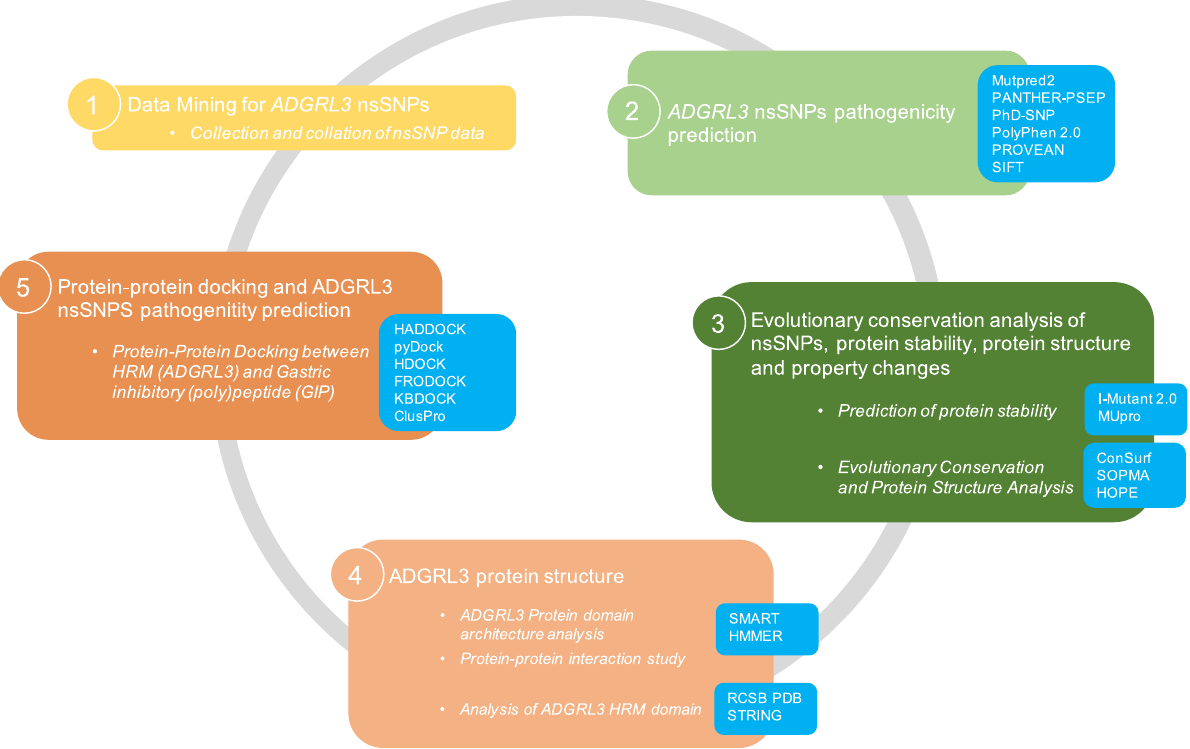
Figure 6. Flow diagram for the in-silico analysis strategy of ADGRL3 nsSNPs conferring susceptibility to ADHD. Blue squares correspond to in-silico tools used for specific analyses. See “Methods” for more